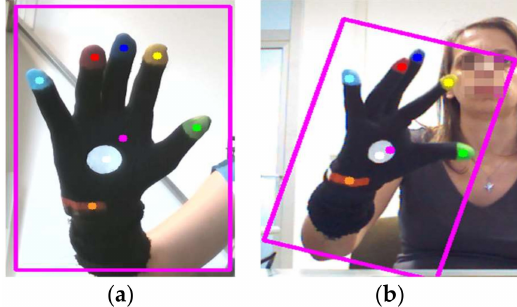
Figure 2. Result of the hand segmentation and the detection of color markers; bounding box of the hand with glove and centroids of the color blobs: ( a ) open hand in static and frontal pose; ( b ) semi-closed hand in dynamic and rotated